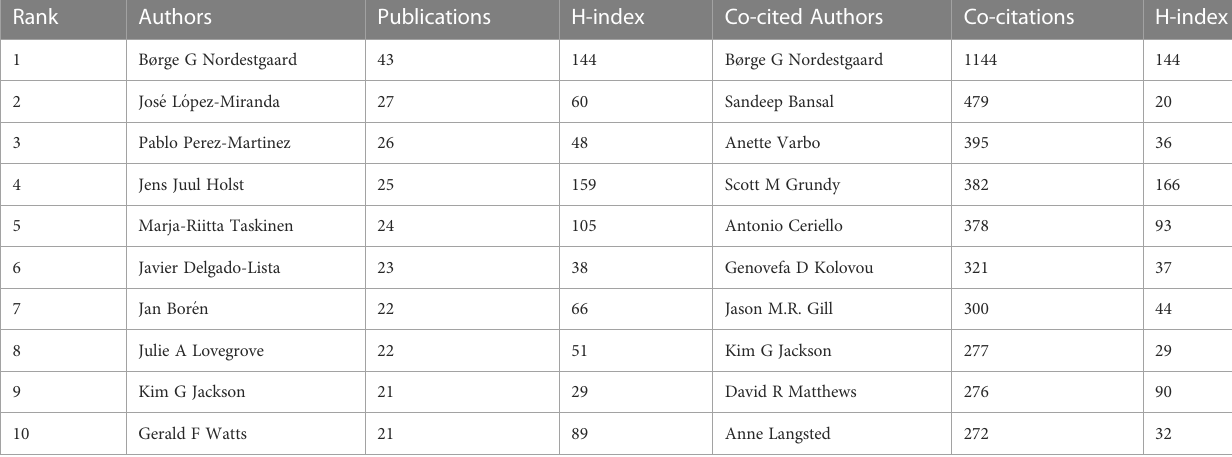
TABLE 2 Top 10 productive authors and co-citation authors in the research fi eld of non-fasting lipid.